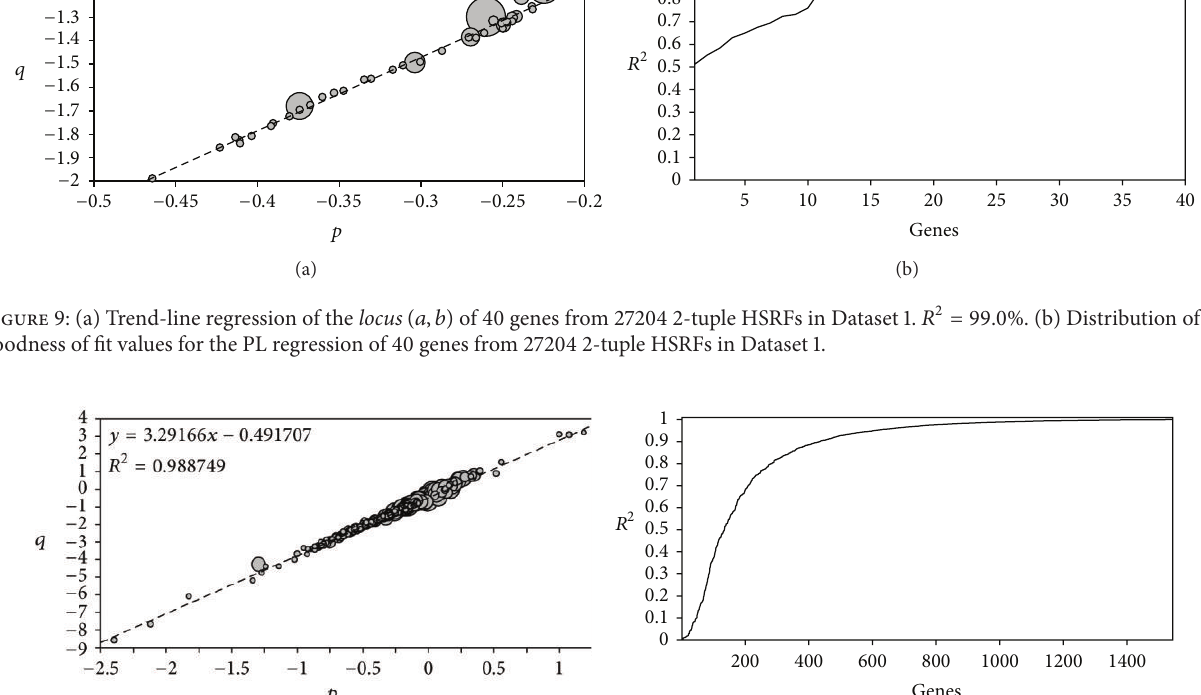
Figure 10: (a) Trend-line regression of the locus (𝑎,𝑏) of 1544 genes from 12412 2-tuple HSRFs in Dataset 2. 𝑅 2 = 98.9 %. (b) Distribution of 𝑅 2 goodness of fit values for the PL regression of 1544 genes from 12412 2-tuple HSRFs in Dataset 2.